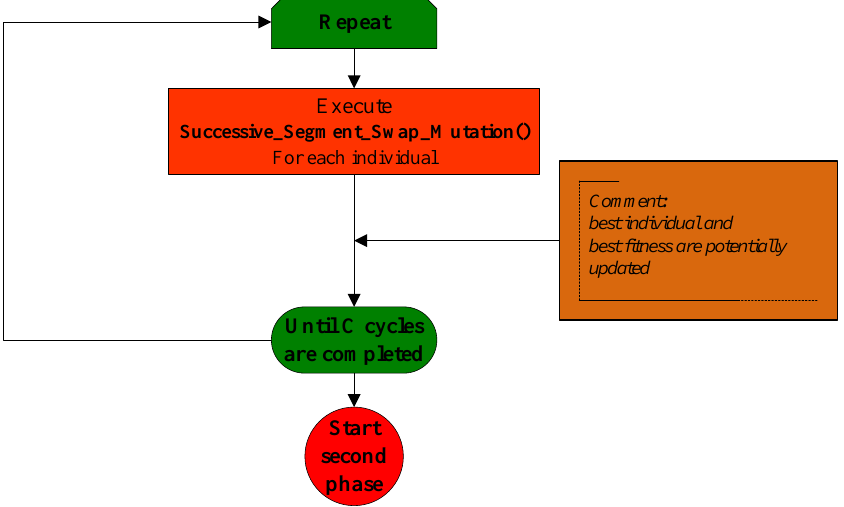
Figure 2. The structure of the first phase of the proposed stochastic variable neighborhood search algorithm.